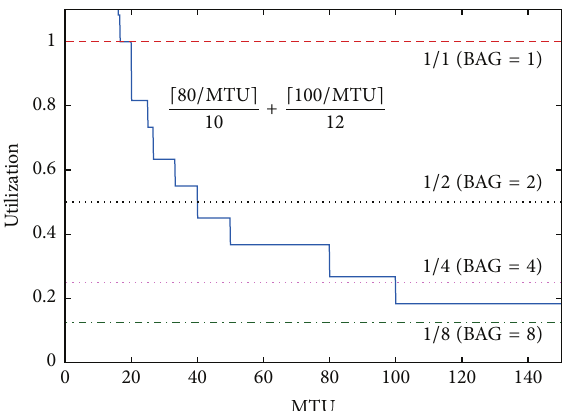
Figure 3: An example of feasible BAG and MTU of a virtual